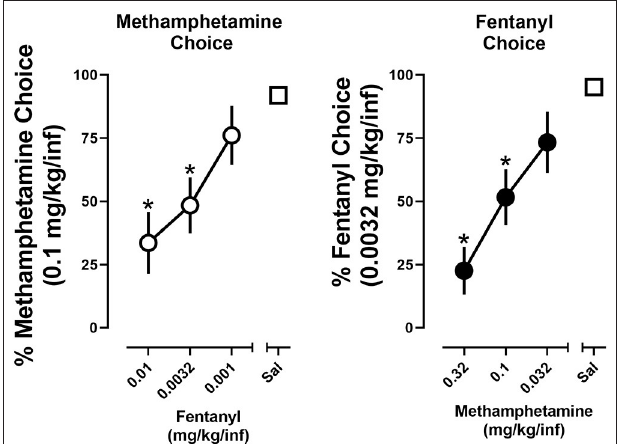
FIGURE 4 | Percent choice of 0.1 mg/kg/infusion of methamphetamine as a function of concurrently available fentanyl dose (or saline) (left) . Percent choice of 0.0032 mg/kg/infusion of fentanyl as a function of concurrently available methamphetamine dose (or saline) (right) . Data represent the mean ± S.E.M. Each point represents 8–12 rats. Asterisks represent a significant decrease from saline ( p < 0.05).